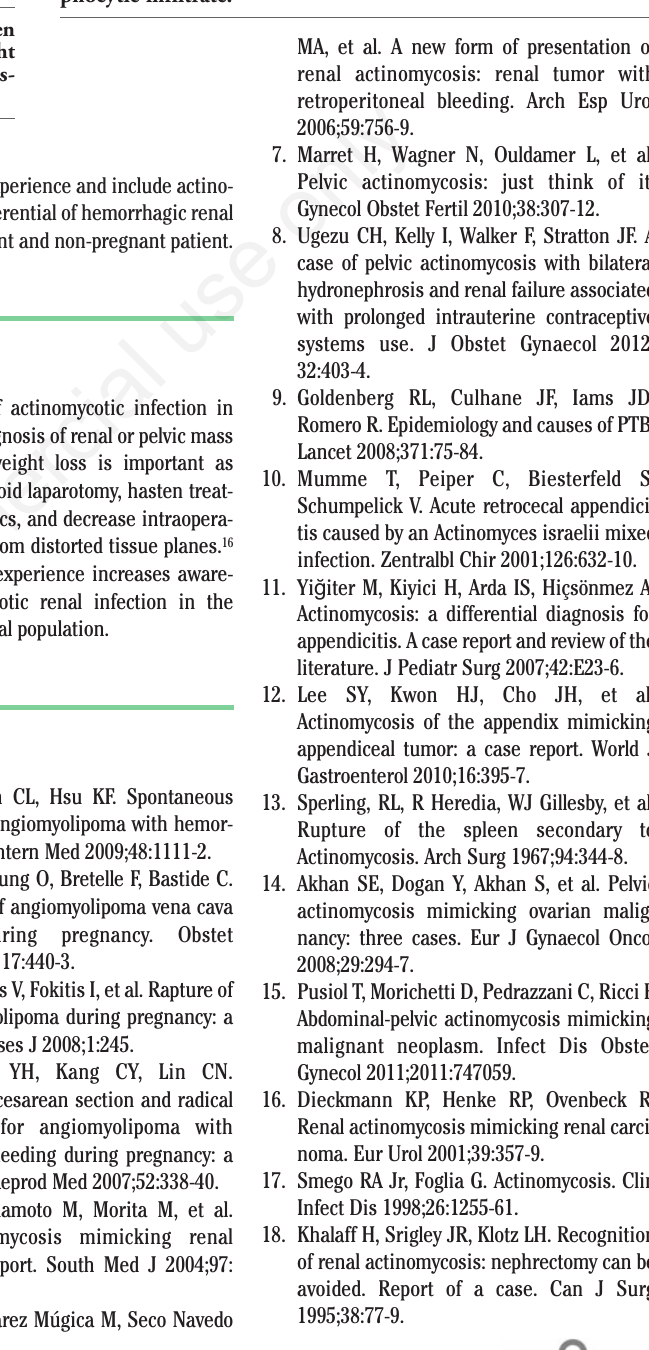
Figure 2. High power view Hematoxylin and Eosin stain of abscess: sulfur granules of actinomyces colonies with dense lym- phocytic